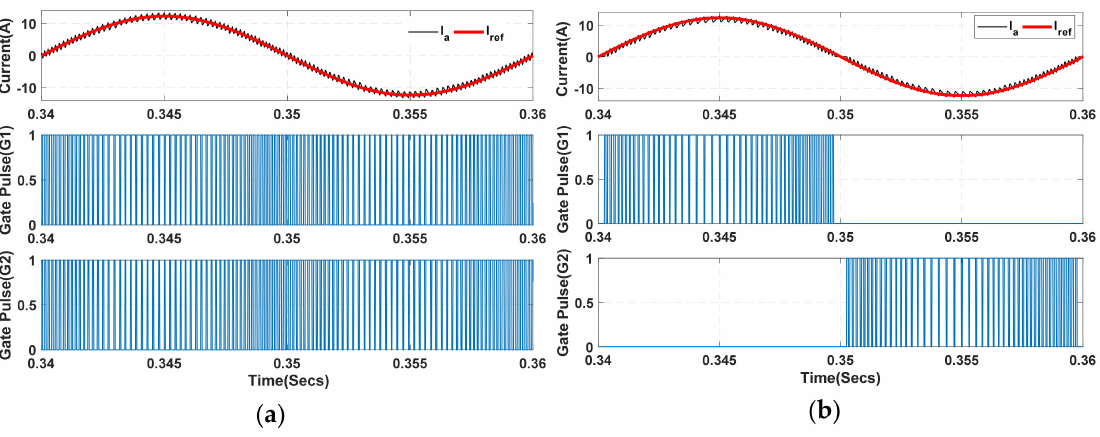
Figure 12. Simulation results showing I ref , I a , and switching pulses for ( a ) IAOA-CHCC and ( b ) IAOA-OFHCC.